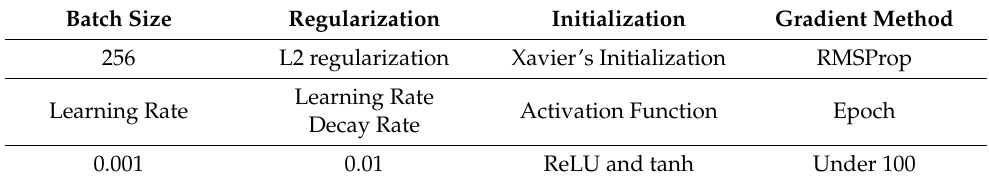
Table 2. Hyperparameters of CAE-model training for the rigid-frame bridge and RC-slab bridge. Batch Size